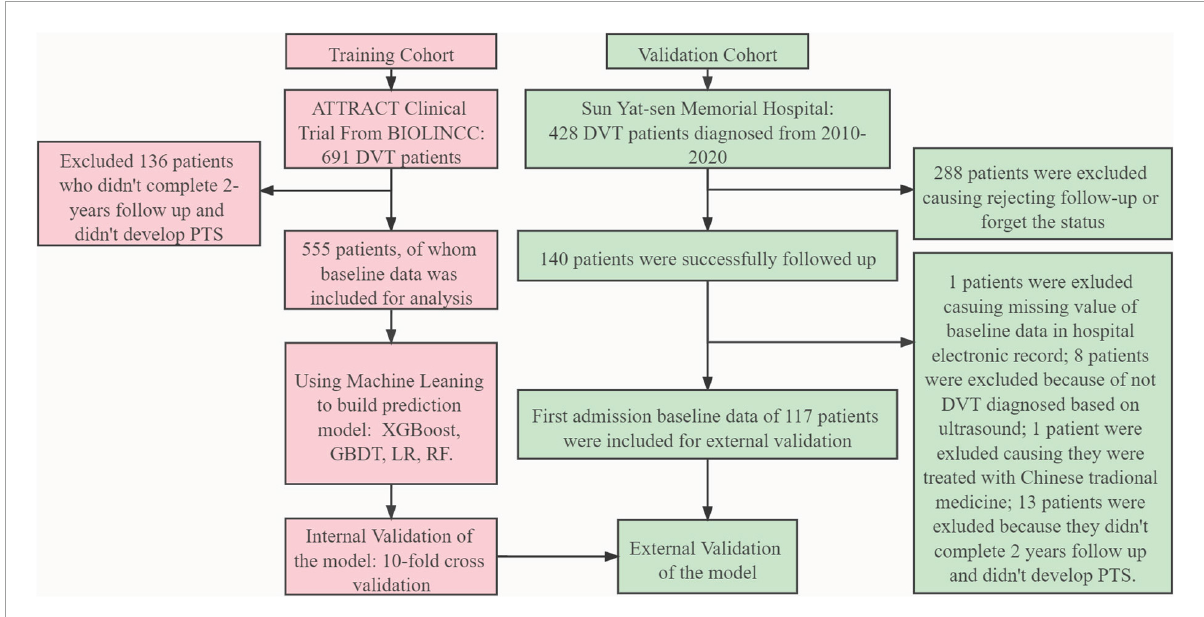
FIGURE1 Model development and evaluation pipeline. ATTRACT, Acute Venous Thrombosis: Thrombus Removal with Adjunctive Catheter-Directed Thrombolysis; BIOLINCC, Biologic Specimen and Data Repository Information Coordinating Center; PTS, post-thrombotic syndrome; XGBoost, eXtreme gradient boosting; GBDT, gradient boosting decision tree; RF, random forest; LR, logistic regression; DVT, deep vein